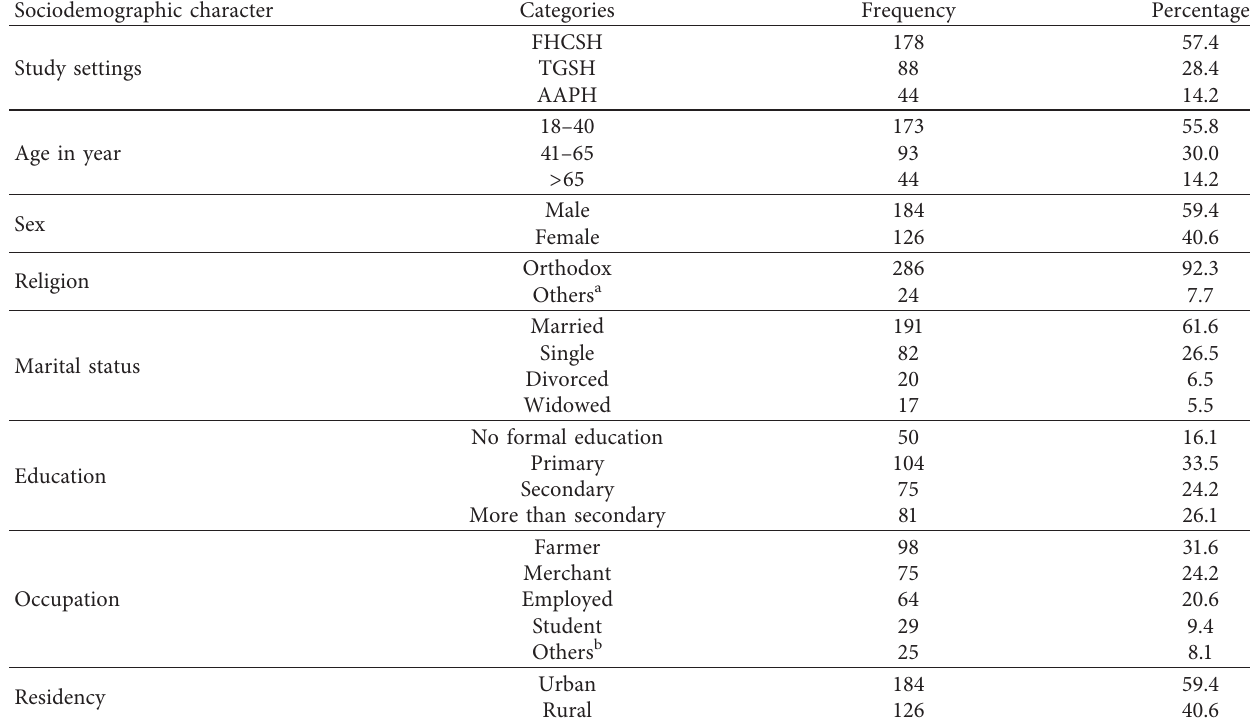
Table 1: Sociodemographic characteristics of adult patients who had undergone abdominal surgery at Bahir Dar City Public Hospitals, Northwest Ethiopia, 2019 ( N �